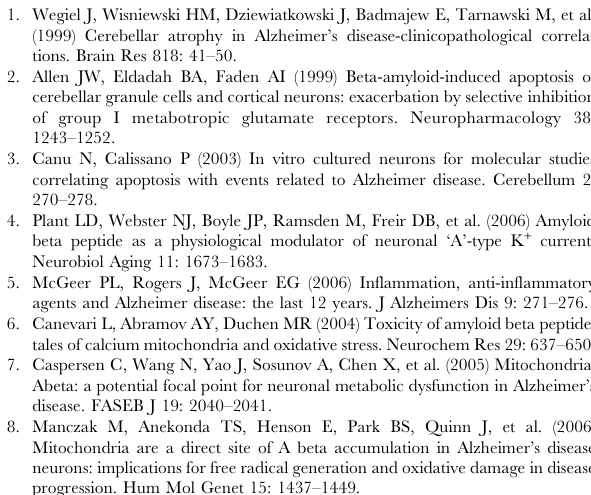
Figure S2 A b 25-35 induces apoptosis and cell death in cerebellar granule cells. A. Cerebellar granule cells were apoptosis was tested by TUNEL assay. Pictures show nuclei (blue)